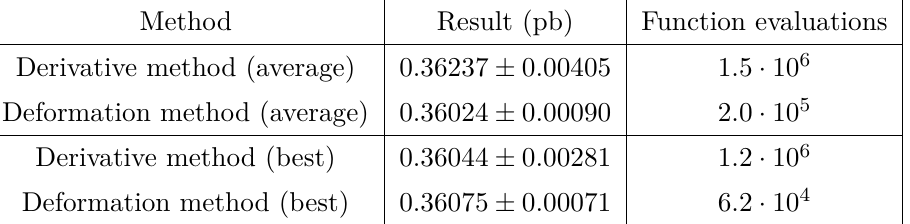
Table 2 . Results and number of function evaluations for the NLL t ¯ th production cross section using the deformation or derivative numerical integration method. The top two rows indicate the average results, and the bottom two the best